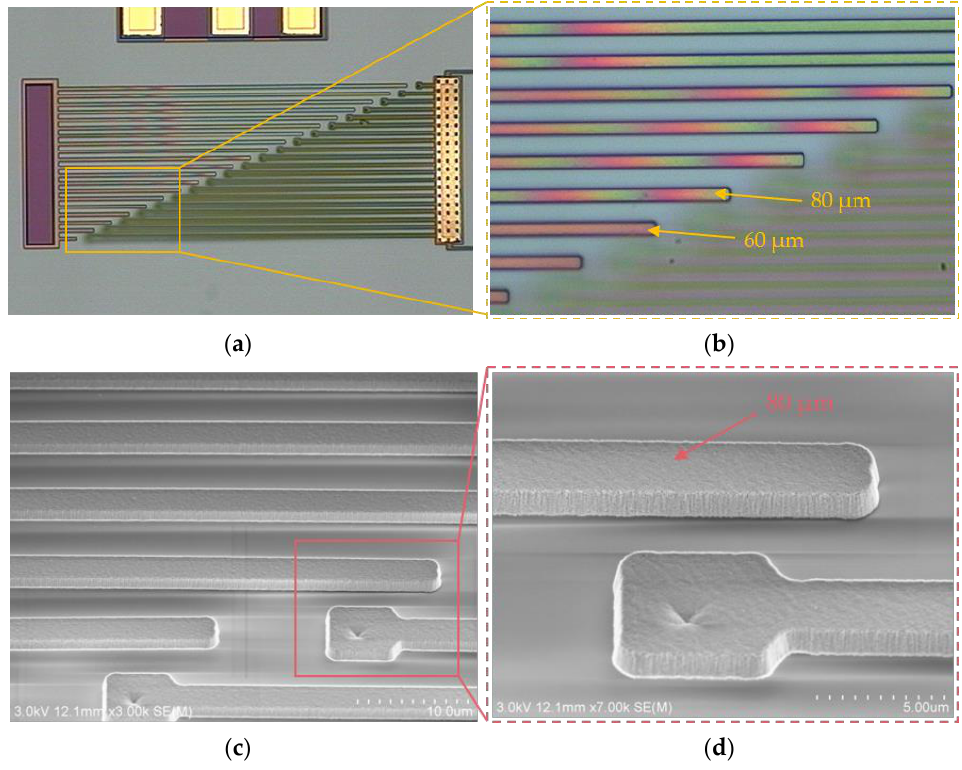
Figure 19. Optical microscopic and SEM views of the cantilever beams after drying at room temperature for 12 h. ( a ) Optical microscopic view of the silicon nitride cantilever beams; ( b ) enlarged optical microscope view of the silicon nitride cantilever beams shows that the tips of silicon nitride cantilever beams longer than 80 μm are bonded to the substrate; ( c ) SEM views of the silicon nitride cantilever beams; ( d ) enlarged SEM view of the silicon nitride cantilever beams shows that the tips of silicon nitride cantilever beams longer than 80 μm are bonded to the substrate.